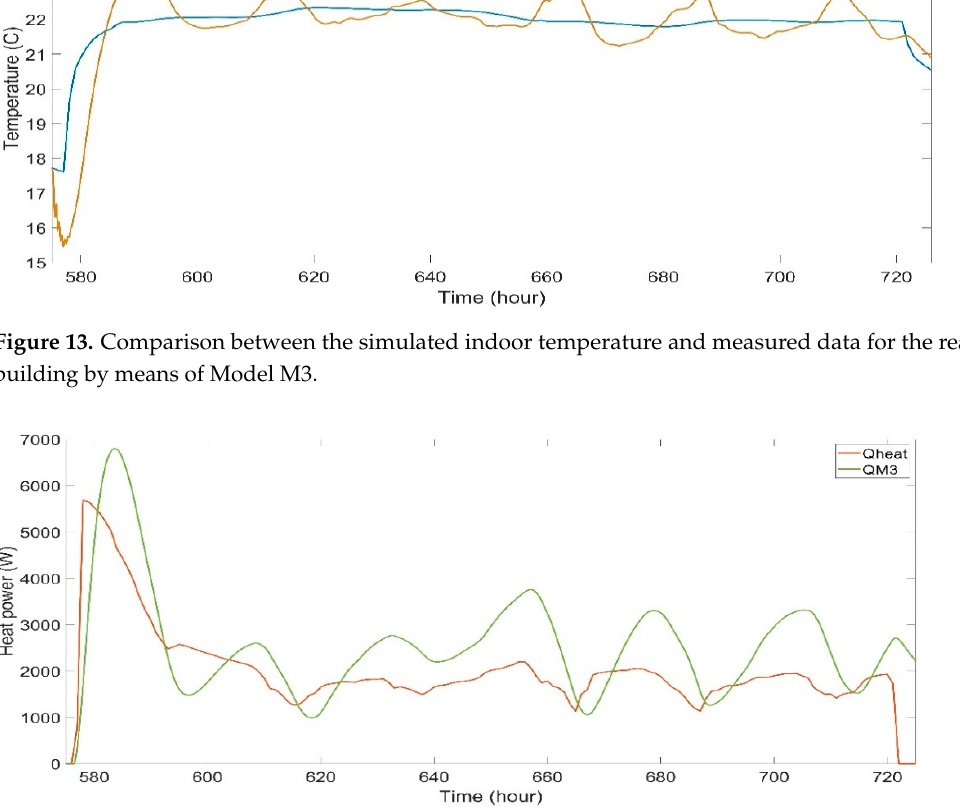
Figure 14. Comparison between the simulated heat power and measured data for the real building by means of model M3.